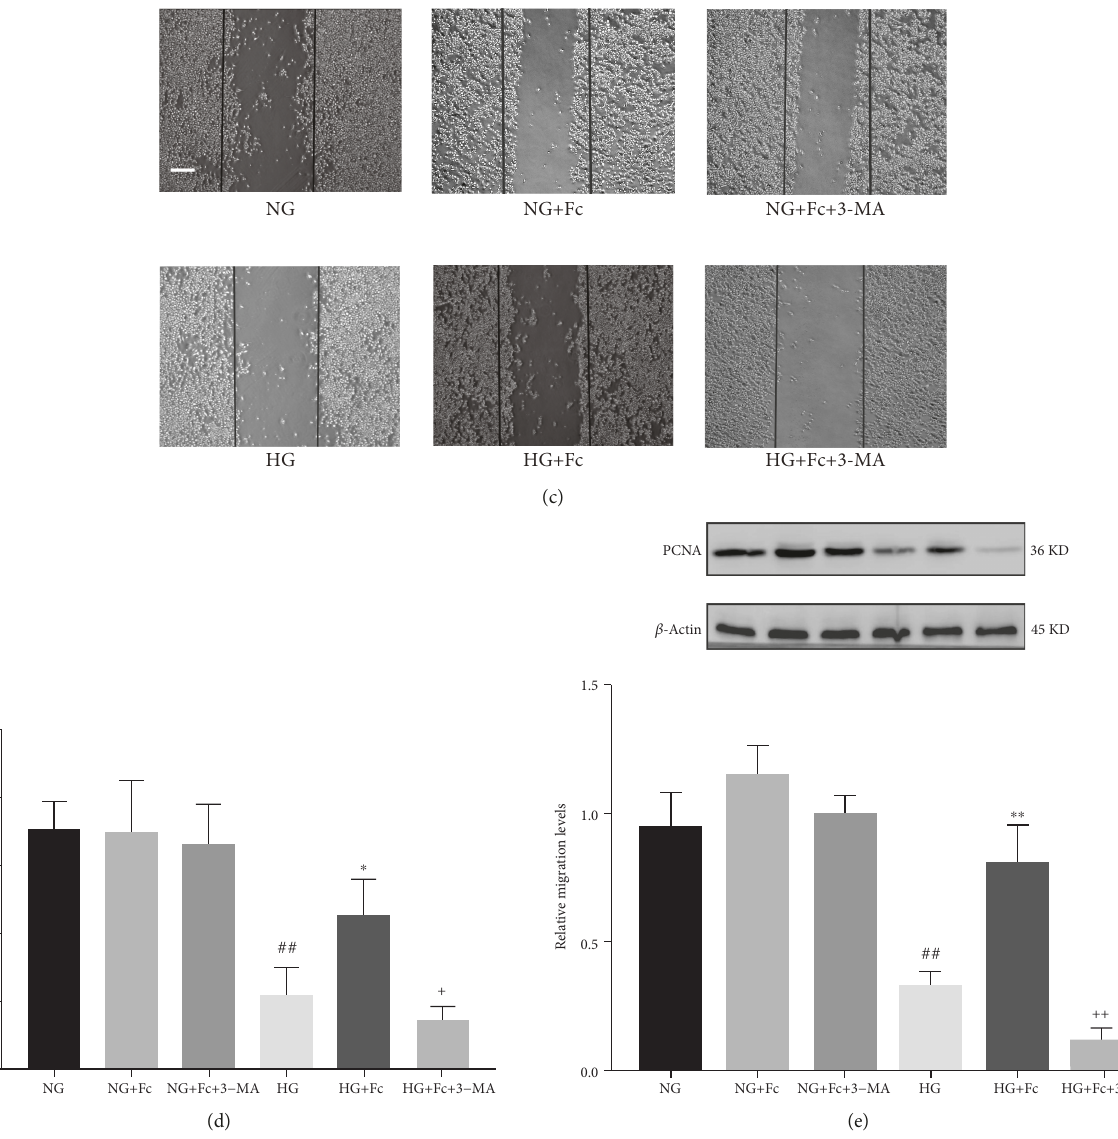
Figure 7: Notoginsenoside Fc (Fc) promotes proliferation and migration via autophagy. (a, b) Cell cycle progression analysis of rat aortic endothelial cells (RAOECs) and G1 arrest rate across treatment groups, as quanti fi ed by fl ow cytometry. (c, d) Representative images of the wound healing assay and wound closure rate in RAOECs across treatment groups. Scale bar = 200 μ m . (e) Expression of proliferating cell nuclear antigen (PCNA) protein was detected by Western blot analysis. # P < 0 05 vs. the normal-glucose (NG) group; ## P < 0 01 vs. the NG group; ∗ P < 0 05 vs. the high glucose (HG) group; + P < 0 05 vs. the HG+Fc group. n = 3